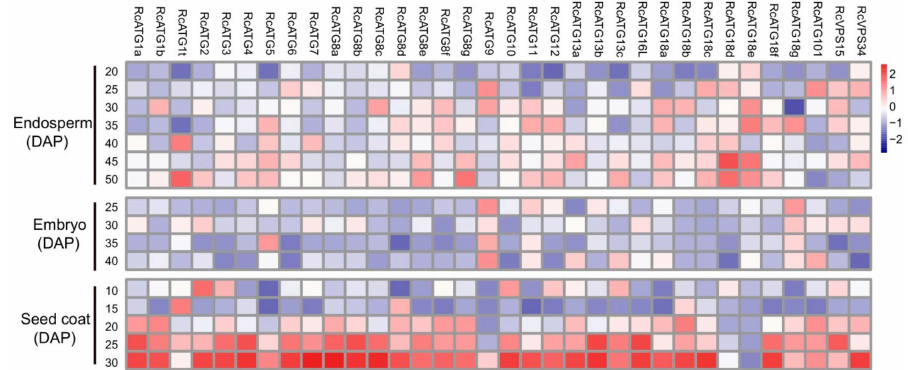
Figure 4. Expression profiles of RcATGs in castor bean seeds. The expression profile was constructed depending on the relative expression level of RcATGs in di ff erent materials. The expression is normalized to RcACTIN2 and the data are means ± S.D. from three biological replicates. Blue boxes indicate the lower transcriptional level of RcATGs , whereas red boxes indicate the higher expression level of RcATGs . The scale bar represents relative expression level after normalization. DAP: days after pollination.